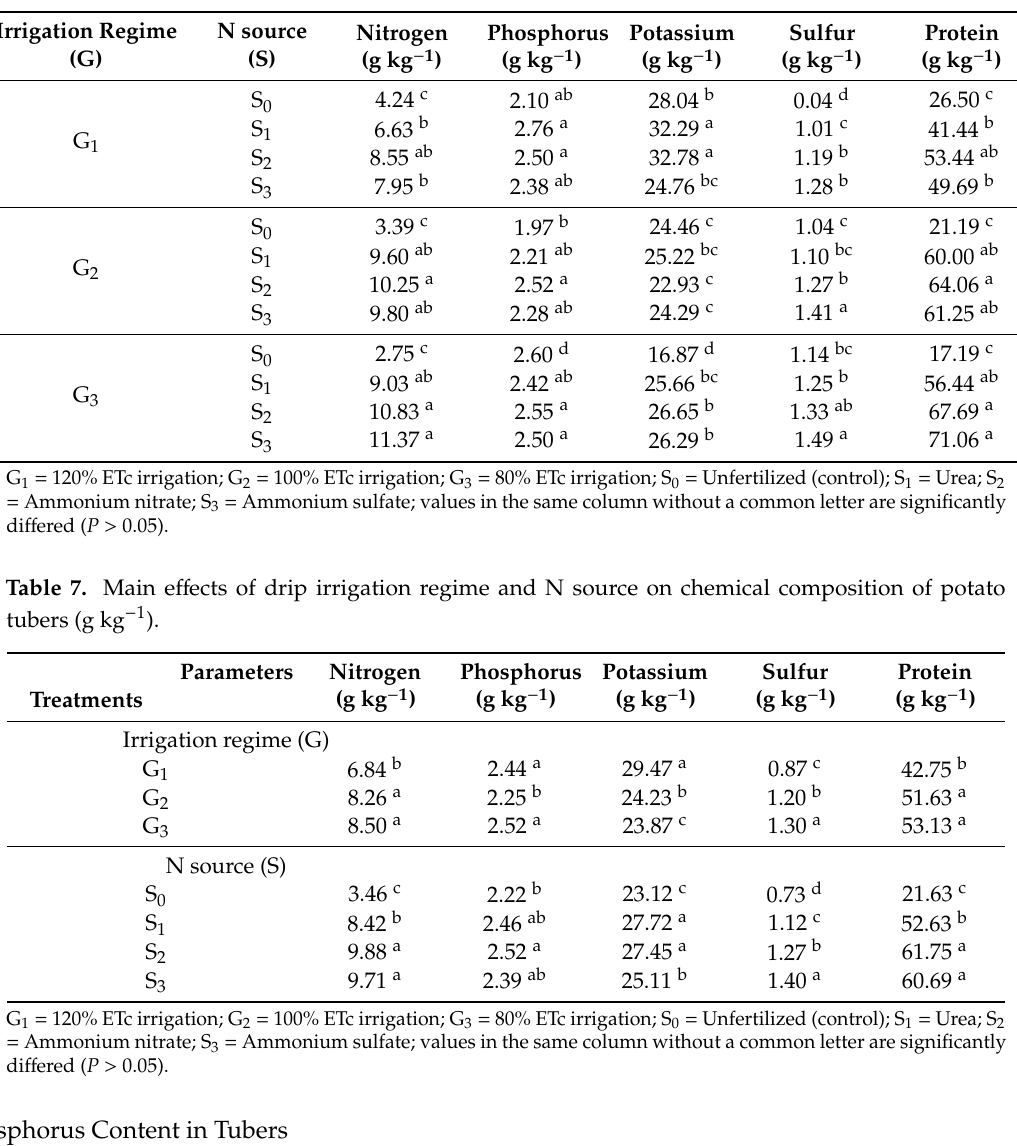
Table 6. Chemical composition of potato tubers as a ff ected by drip irrigation regime and N source interaction.